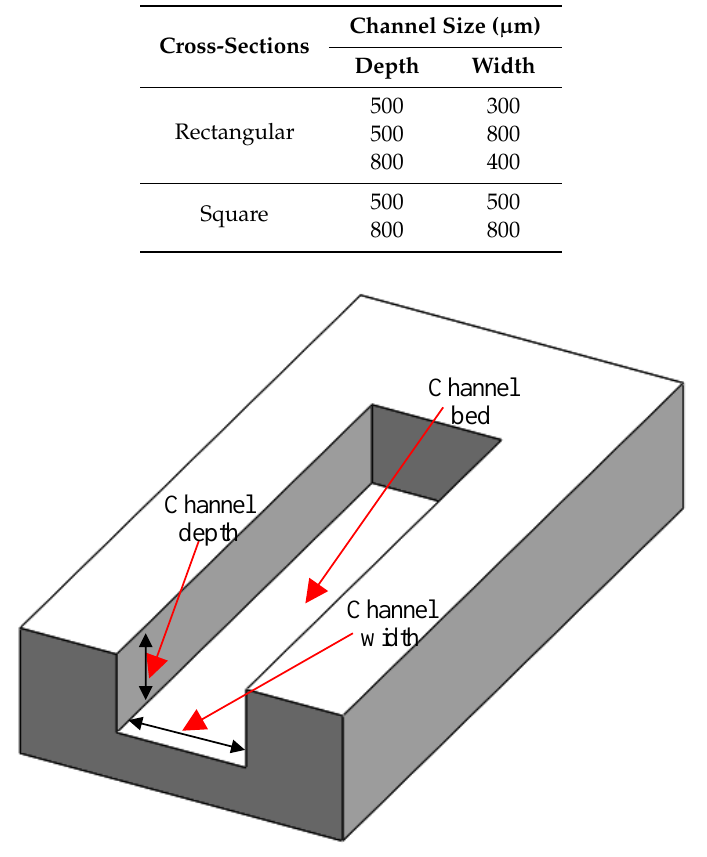
Figure 4. Schematic of microchannel.